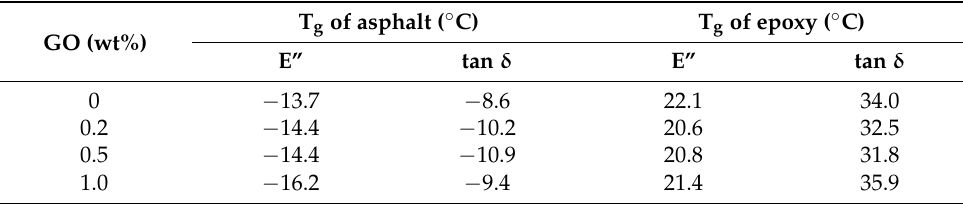
Figure 8. Loss modulus versus temperature curves of the unmodified and GO-modified EABCs. Table 3. T g s of asphalt and epoxy in the unmodified and GO-modified EABCs.